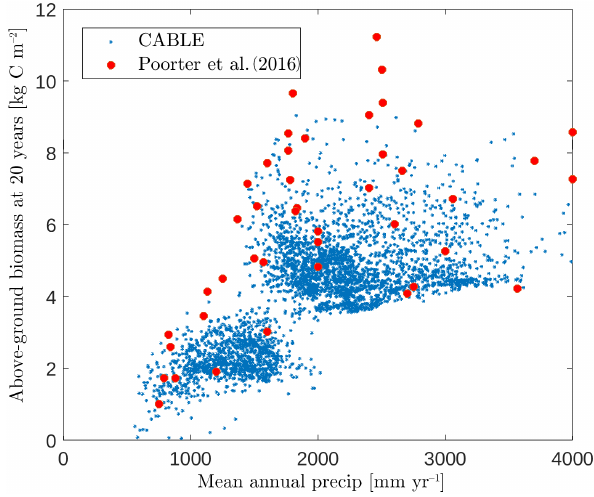
Figure 5. CABLE and observation-based estimates (Poorter et al., 2016) of Neotropical secondary forest biomass after 20 years of regrowth versus mean annual precipitation. CABLE estimates are extracted from secondary forest tiles in tropical rainforest, tropical seasonal forest and tropical dry forest–savanna biomes (Fig. 2) in South America. The lower distinct cloud of CABLE-simulated val- ues corresponds to the tropical dry forest–savanna